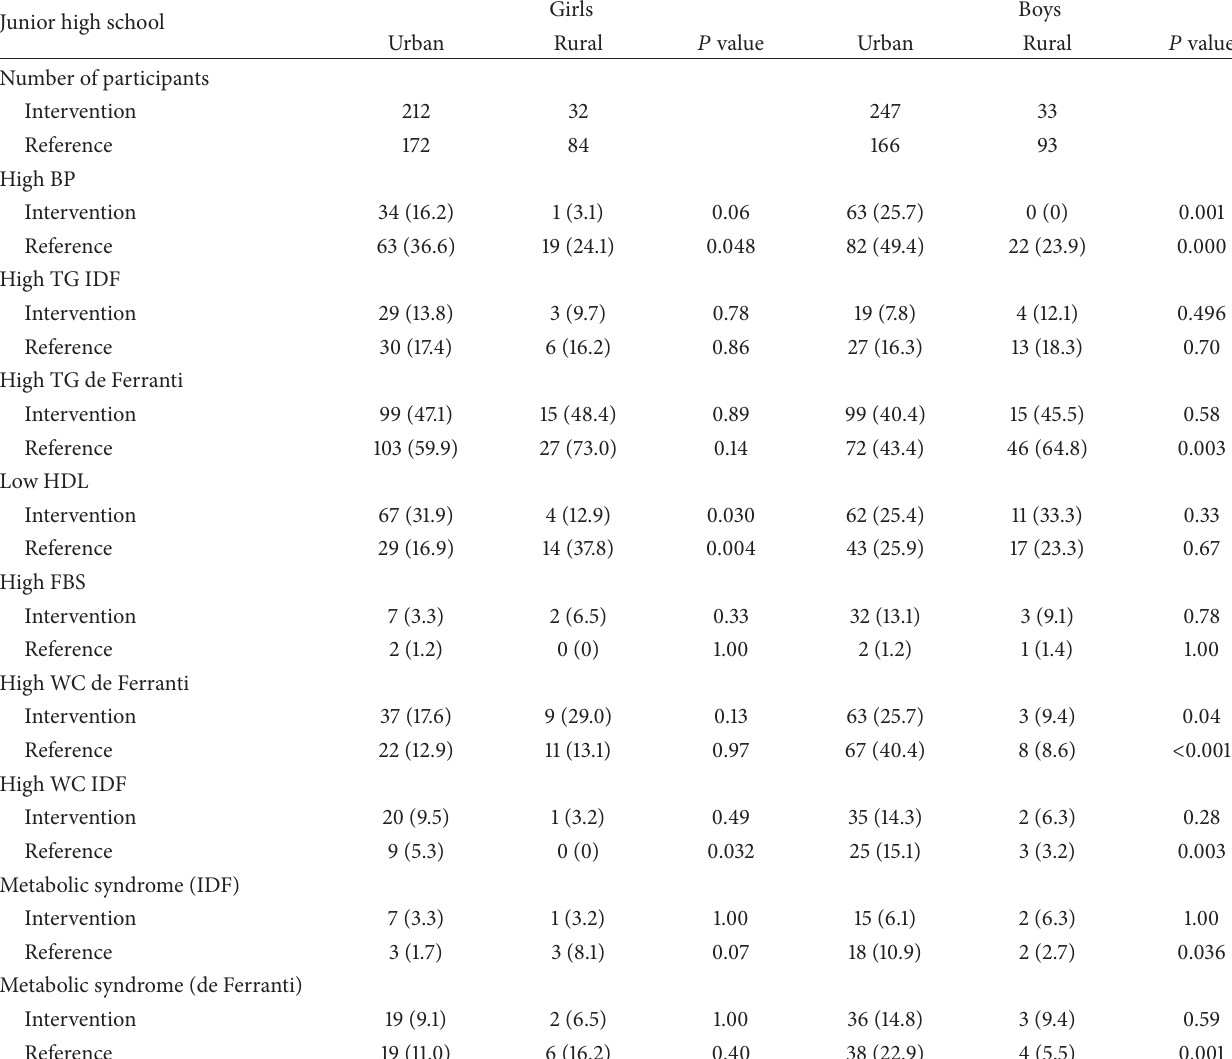
Table 2: Prevalence of different components of metabolic syndrome in junior high school students urbanization and intervention, reference. Junior high